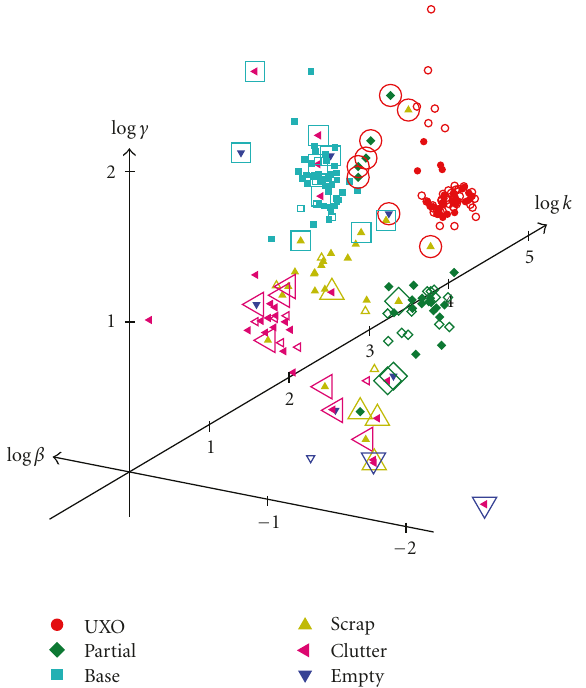
Figure 9: SVM classification of the Camp Sibert anomalies using the logarithms of k , β , and γ . The SVM has C = 9. The small markers denote the ground truth for both training and testing cells. The larger markers highlight the cases where there is a disagreement between the ground truth and the SVM